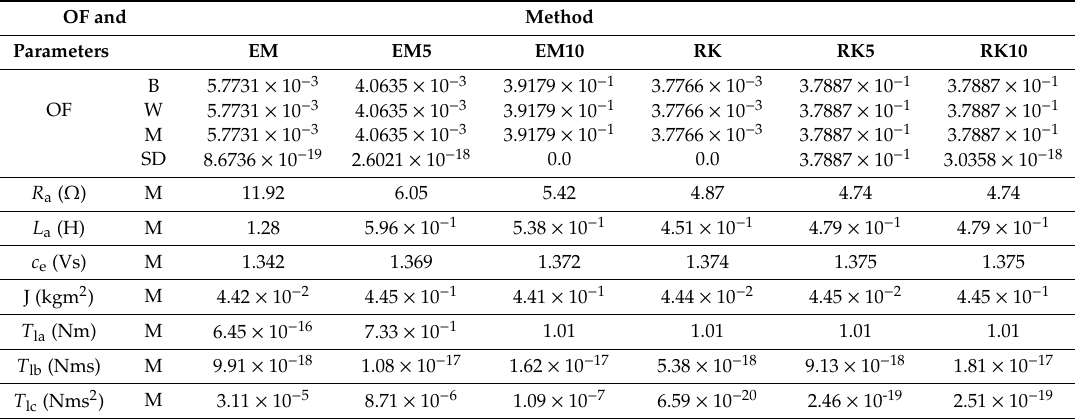
Figure 20. Measured and calculated responses in the case of MD2 using: ( a ) EM10; ( b ) RK10. Comparing Figures 9 and 20, especially the improvement achieved with EM10 can be seen. MD3 are presented in Table 26. Table 26. OF and Mean values of the calculated parameters for 50 independent runs using EM, EM5, EM10, RK, RK5, and RK10 for MD3.